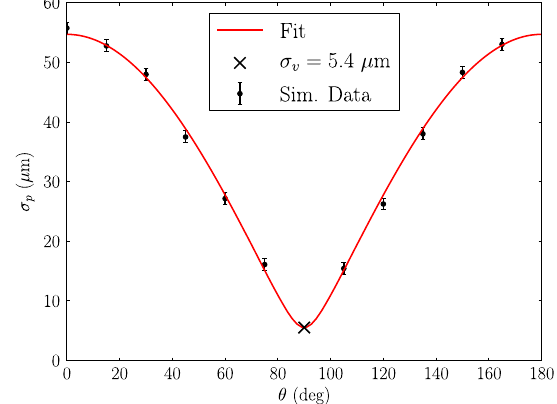
FIG. 14. Simulated 5 μ m vertical beam size reconstruction using the rotated SRI technique using SRW. Black dots are the SRW simulated data, the error bar is fixed to 1 . 5 μ m, and red line is the result of the fit using Eq. (12). The black cross indicates the result from the fit for the σ v .